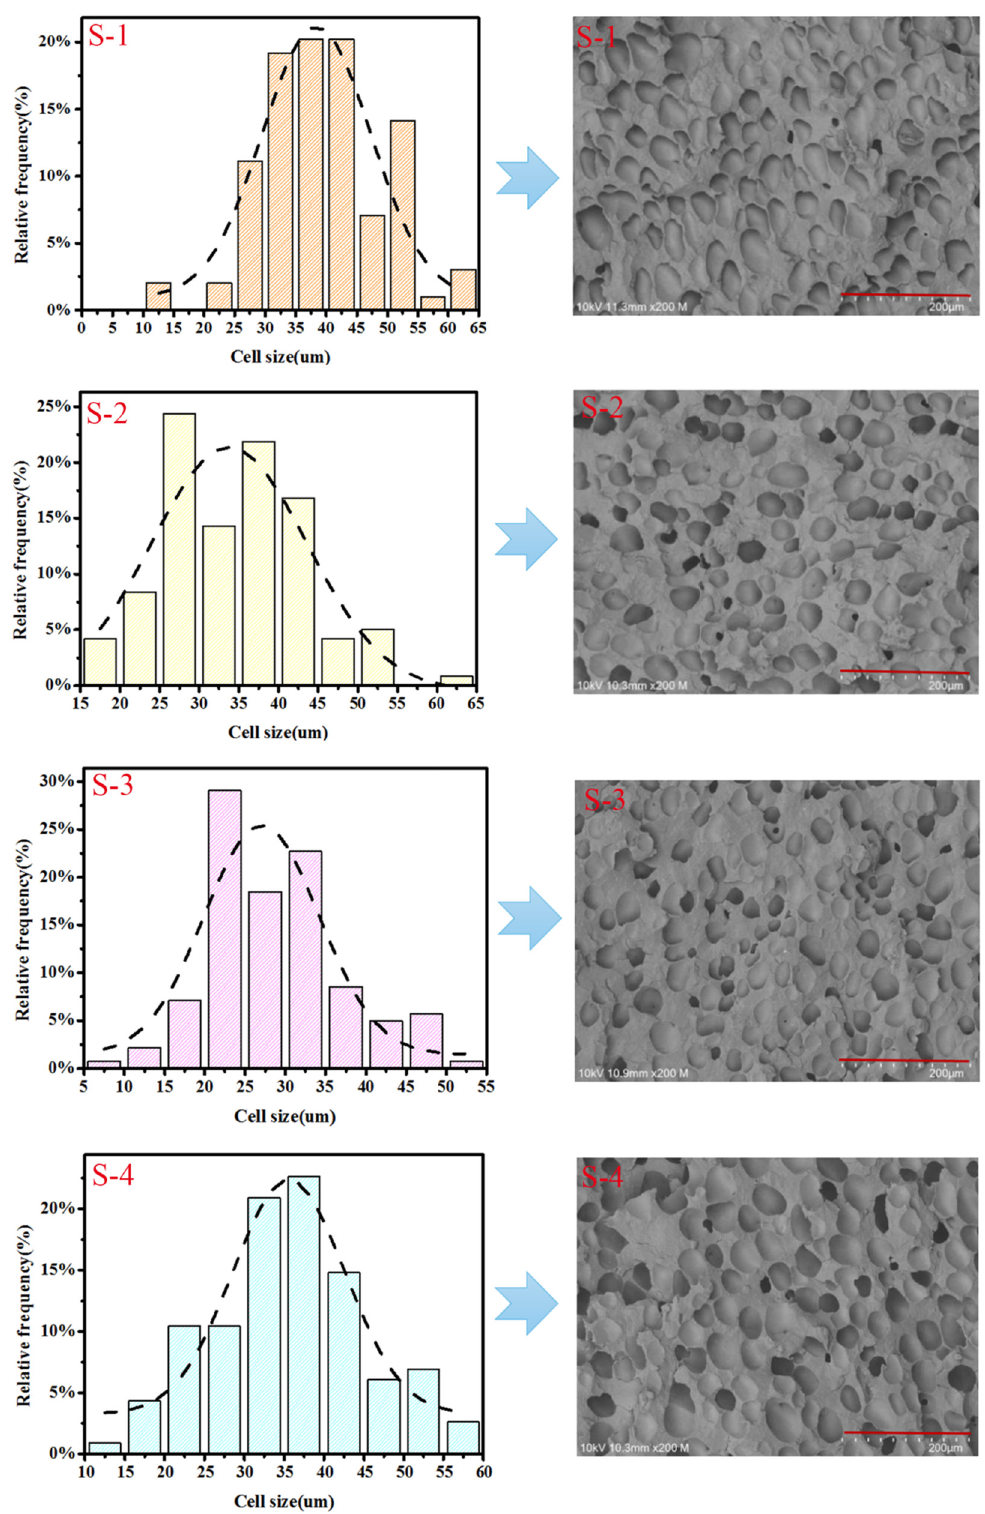
Figure 9: Foaming quality of foamed PP composites in di ff erent